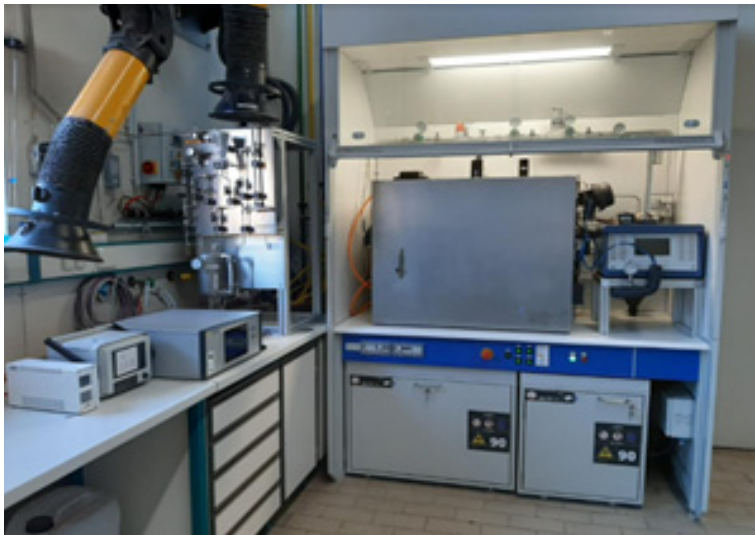
Figure 5. Online conditioning and analysis system of ALFE_CH3OH_PLP.